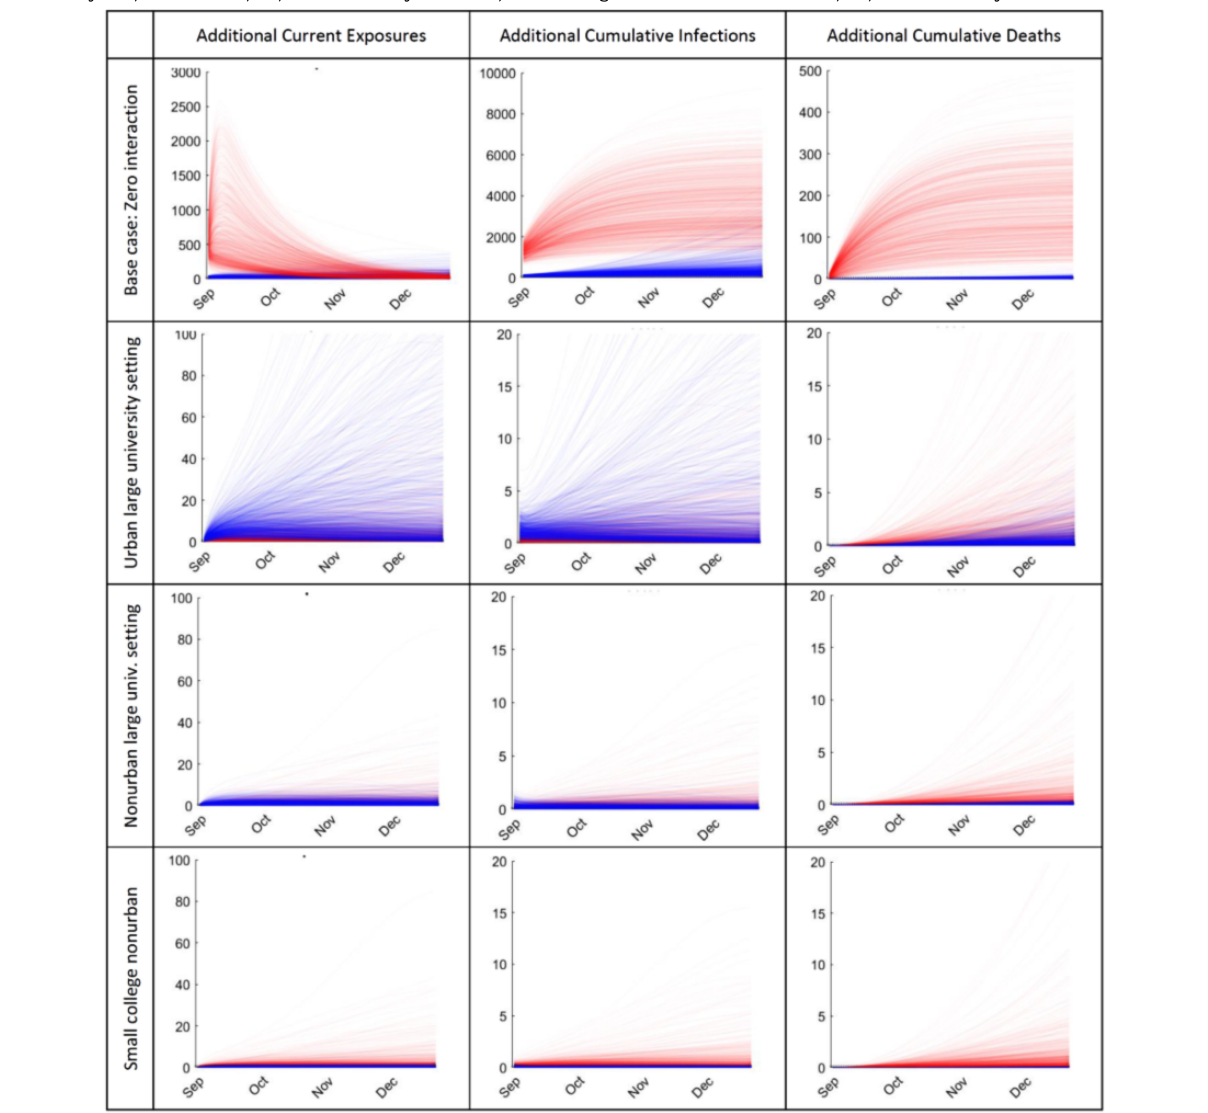
Figure 4. Impact of school-to-community population sizes on predicted additional community resident (red) and student (blue) COVID-19 current exposures, total infections, and total deaths per 10,000 individuals during the fall 2020 semester, assuming 1% prevalence among returning students and effective campus operations precautions (50% R0 reduction). Urban large university: 10,000 students, 100,000 community residents;